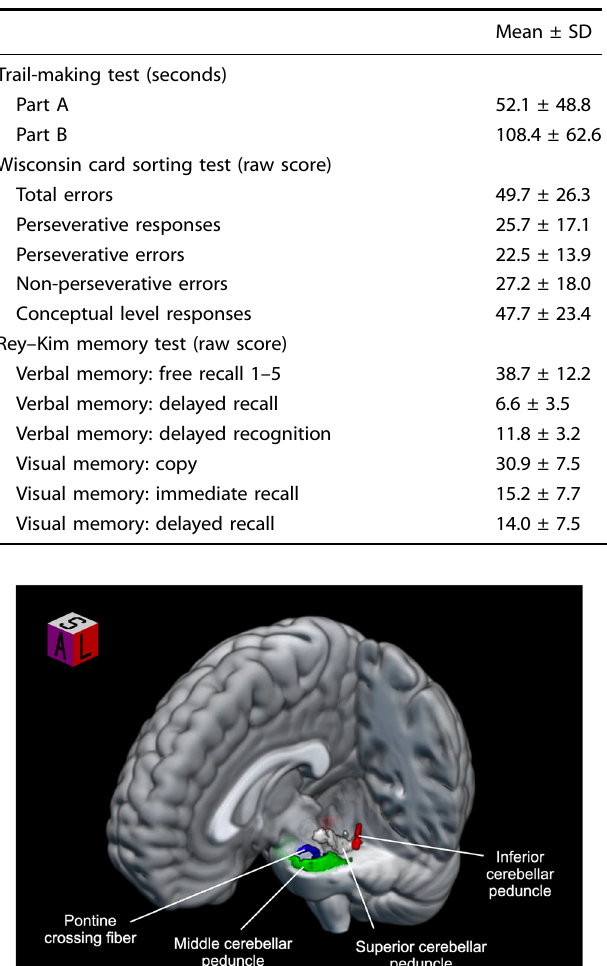
Table 2. Cognitive performance in participants with schizophrenia ( n = 46).